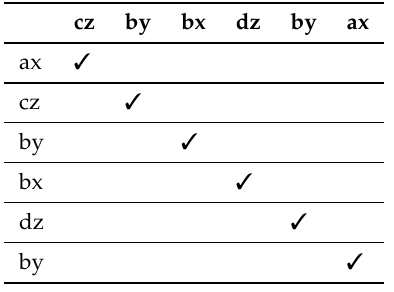
Table 14. MR-I results for chainResponse constraints (activation and